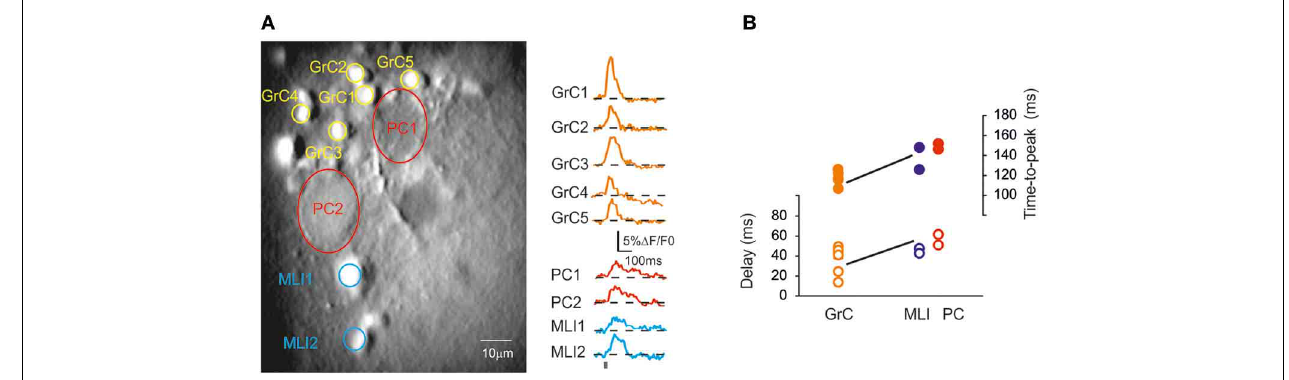
FIGURE 7 | Cerebellar circuit responses I: neuronal activation sequence. (A) High magnification (40 × ) image of a cerebellar slice bulk-loaded with Fura-2AM, in which different cell types can be distinguished. Traces on the right show the signal generated by GrCs, PCs, and MLIs following stimulation of the mossy fiber bundle (10 pulses